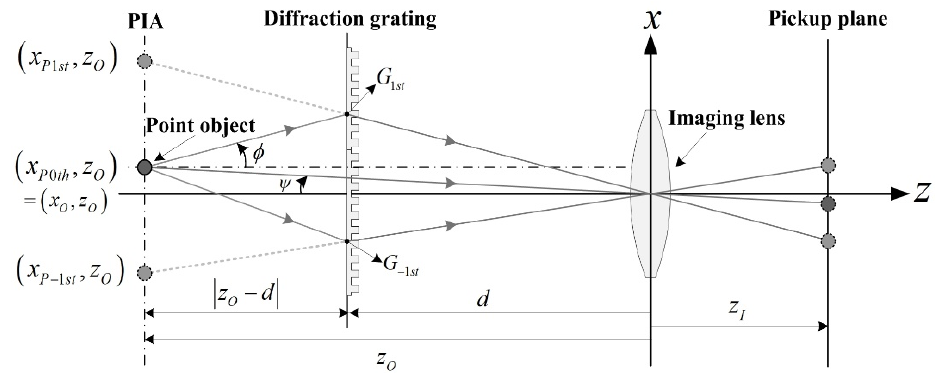
Figure 2. Parallax angle of a point object, ϕ , corresponds to the 1st order parallax image.